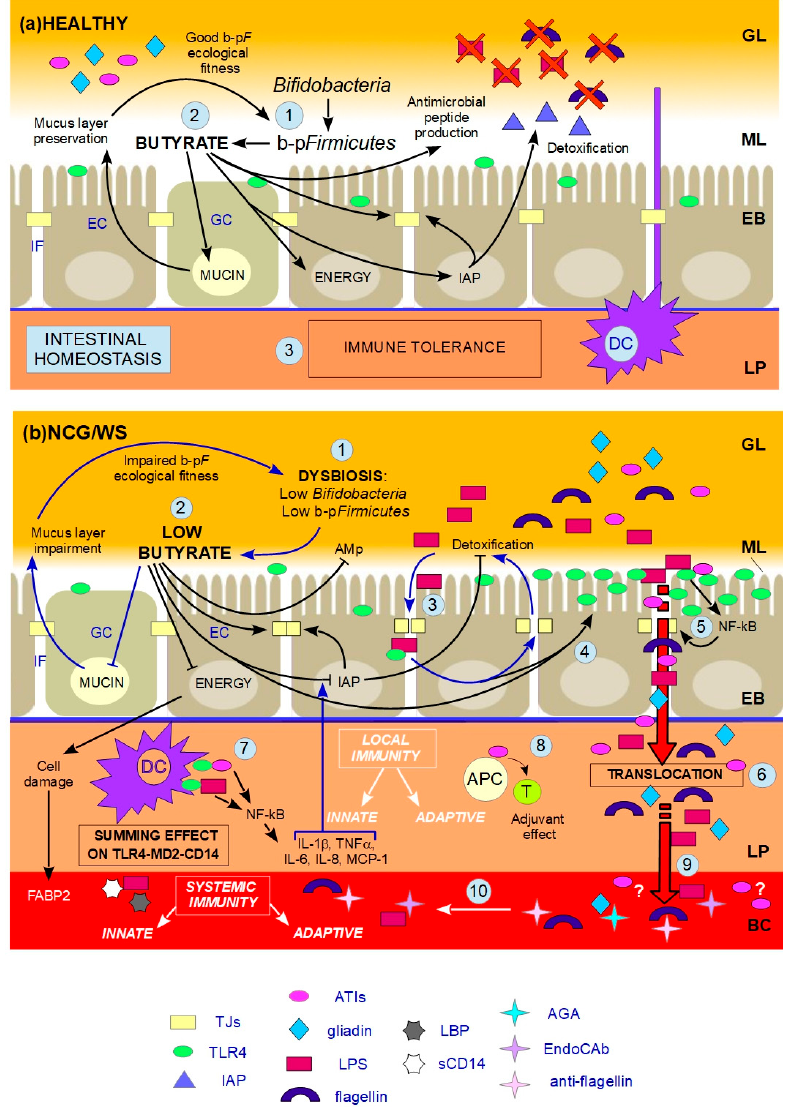
Figure 1. Schematic drawing that shows what happens in a healthy gut versus a non-coeliac gluten/wheat sensitivity gut according to our hypothesis. NCG/WS = non-coeliac gluten/wheat sensitivity; EC = enterocyte; GC = goblet cell; IF = interstitial fluid; GL = gut lumen; ML = mucus layer; EB = epithelial barrier; LP = lamina propria; BC = blood circulation; numbers in light blue balloons indicate the various steps in the chain reaction; → indicates stimulation; indicates inhibition. ( a ) HEALTHY: 1. Butyrate-producing Firmicutes (b-p F ) provide adequate levels of butyrate in the ML and Bifidobacteria support the production of butyrate thanks to cross-feeding interactions with b-p F. 2. Butyrate in the ML, close to ECs, plays different trophic and protective functions: it stimulates GCs